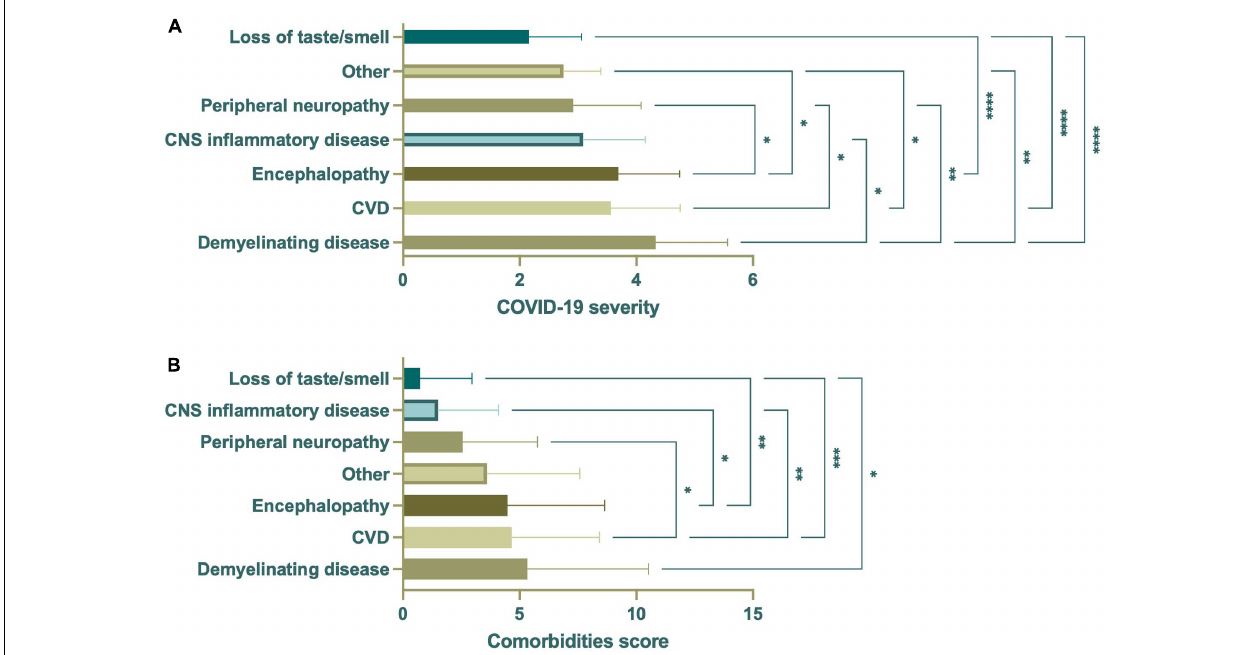
FIGURE 8 | ANOVA of COVID-19 severity or comorbidities score by neurological disease category ( n = 350). Significant differences in mean COVID-19 severity (A) were seen among all neurological disease categories. Demyelinating disease had the highest mean, with CVD and encephalopathy second and third. Similarly, demyelinating disease had the highest mean comorbidities score, with CVD and encephalopathy second and third (B) . Loss of taste/smell had the lowest mean COVID-19 severity and comorbidities score. Data were derived from the same subjects. * p < 0.05; ** p < 0.01; *** p < 0.001; **** p <